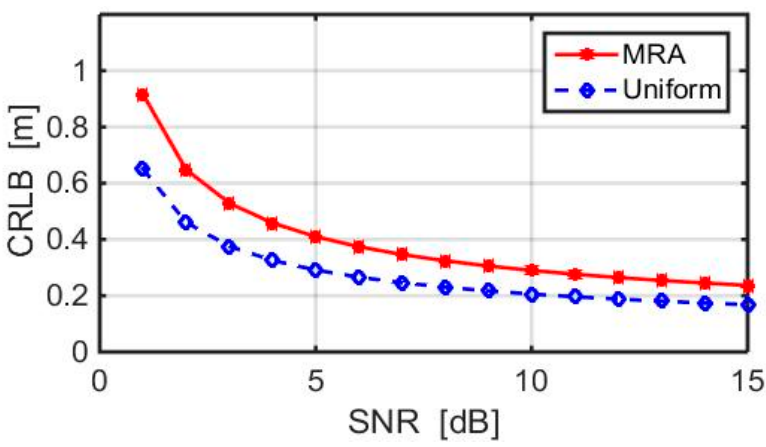
Figure 6. Cramer-Rao Lower Bound (CRLB) at different SNR levels.